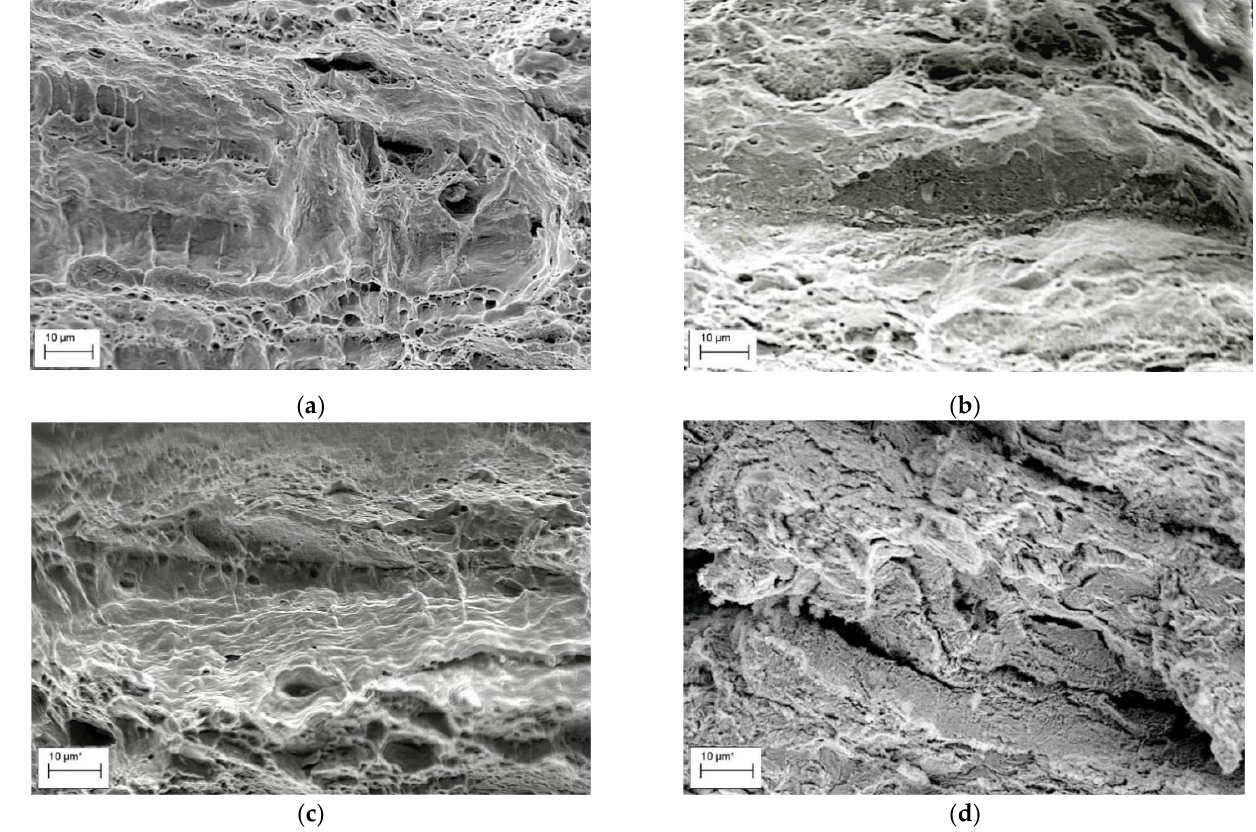
Figure 4. Fractograms of the specimens made of the 17H1S ( a , b ) and X70 ( c , d ) pipeline steels after operation for 30 ( a , b ) and 37 ( c , d ) years, fractured after tensile testing in air ( a , c ) and NS4 solution ( b , d ).